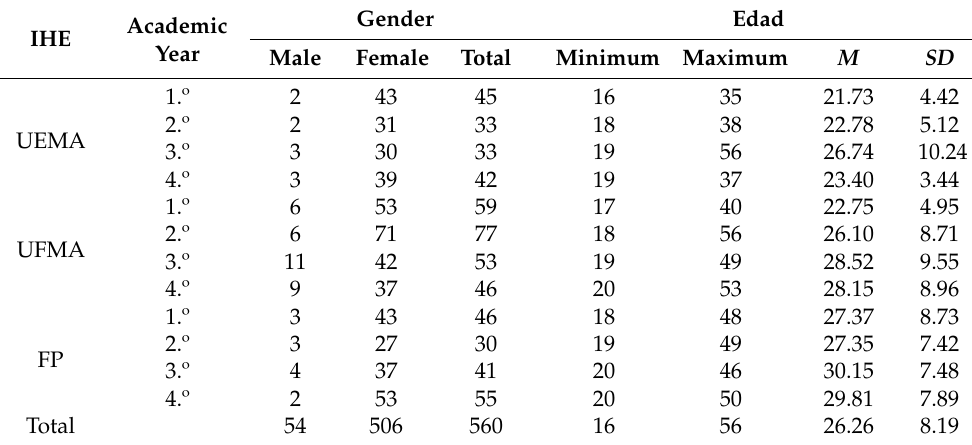
Table 1. Characteristics of the participants of this